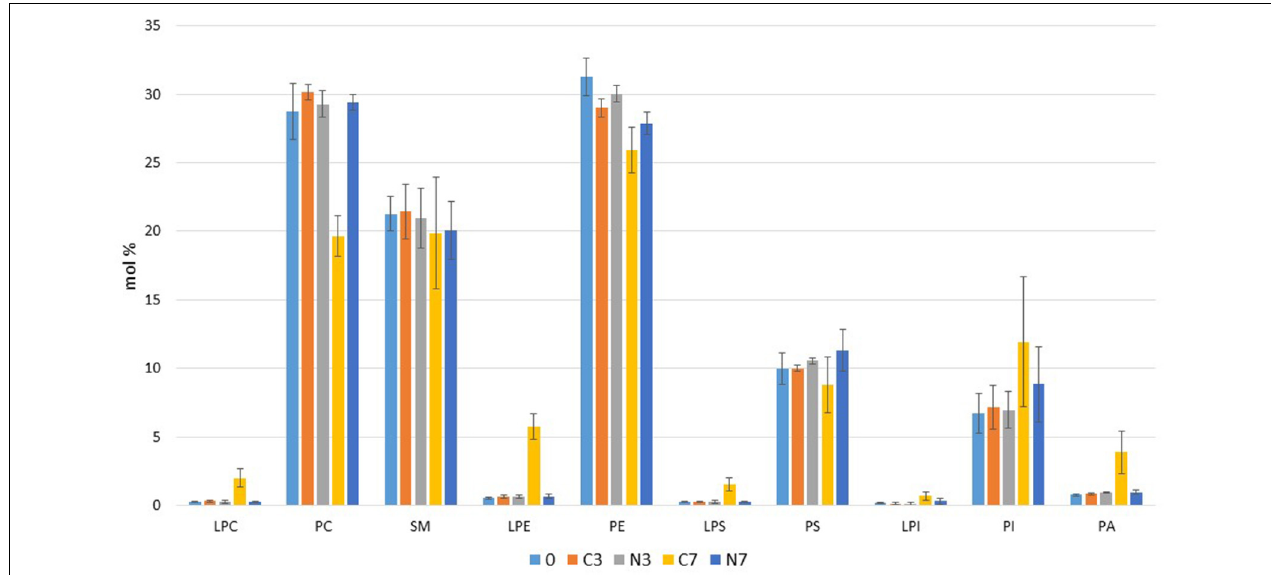
FIGURE 3 | Profiles of phospholipid classes detected in bovine raw milk samples (M1, M2, and M3) (in mol%) at the initial stage (0) and after 3 and 7 days in cold-stored (C3, C7) and in cold-stored while N 2 -flushed (N3, N7) conditions. LPC, lysophosphatidylcholine; PC, phosphatidylcholine; SM, sphingomyelin; LPE,